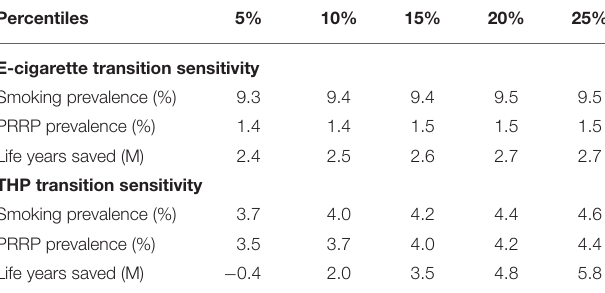
TABLE 7 | Sensitivity percentiles for all 1,000 projections for the E-cigarette and THP